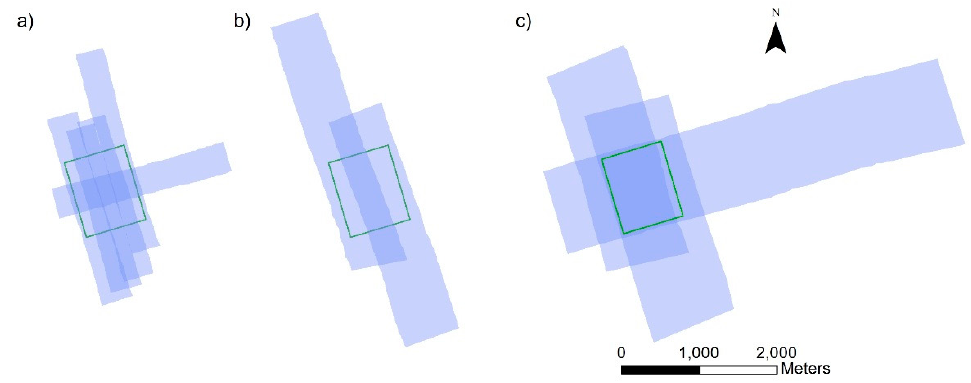
Figure 2. Swath coverage of the AOI by lidar at altitudes: ( a ) 500 m; ( b ) 1000 m; ( c ) 1500 m. Table 1. Lidar parameters for each swath. *PRF (Pulse Repetition Frequency) is given for one channel.